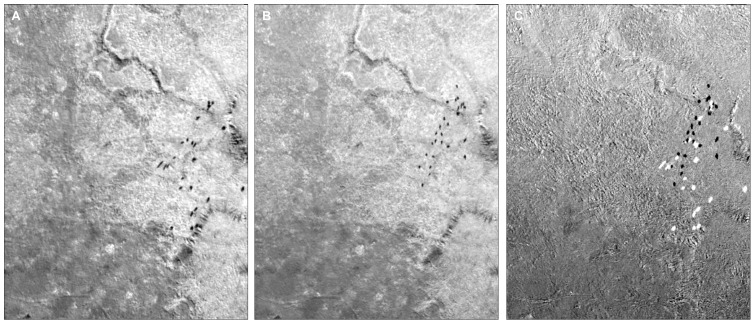
Section of pasture 29 depicting 22 known animals.Figure A is the 1st principal component of the first image acquired (T1), figure B is the 1st principal component of the second image acquired (T2), and figure C is the differenced image resulting from subtracting T1 from T2.